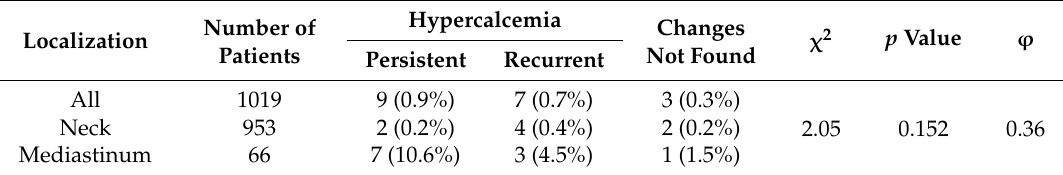
Table 5. Persistent and recurrent